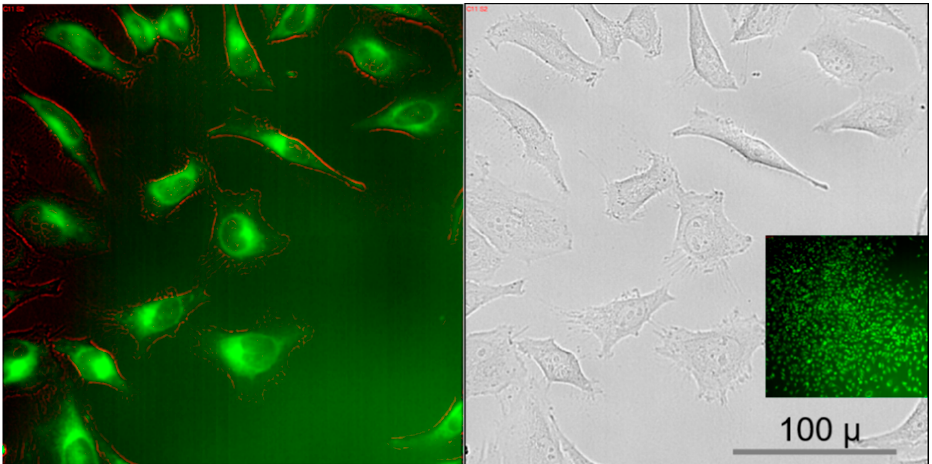
Figure 3. Images of HeLa cells directly after application of auto-fluorescent curcumin (10 µL of a CD-CC-NP aqueous suspension containing 1.8 µg CC were added to 100 µL well volume; red lining is due to artificial coloring for better visualization of cell morphology). The GFP channel is compared to the bright field image (magnification 40×). Inset: CC fluorescence is visible in all cells in the well, here imaged with a 10x objective.